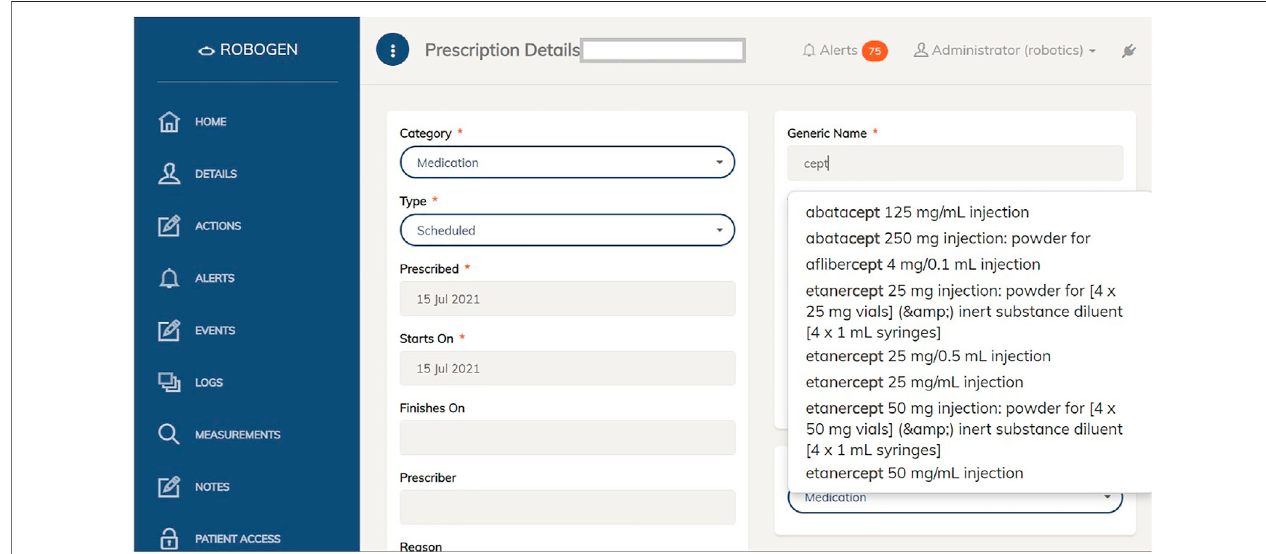
FIGURE 2 | RoboGen2 user interface: medication selection search function.